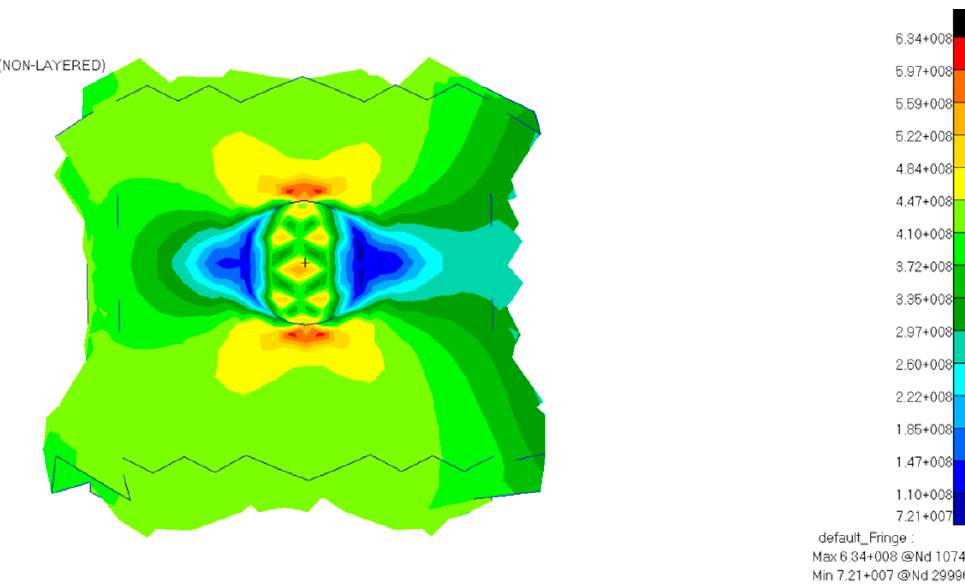
Figure 17. Von Mises distribution on the 20 µm microcapsule.